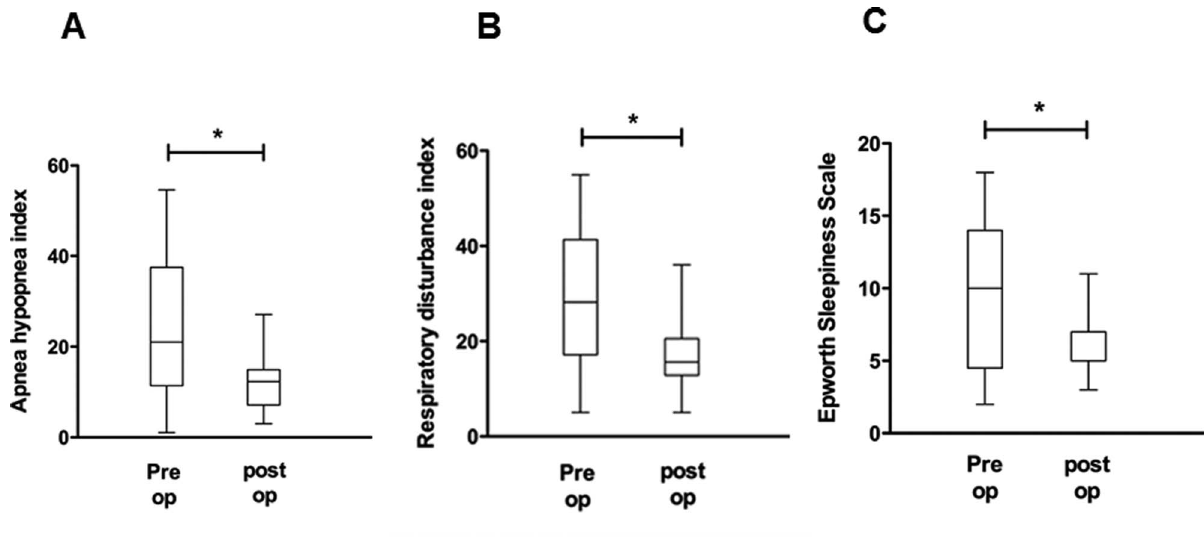
Figure 3. Changes in watch-PAT-derived factors, such as AHI (A), RDI (B), and ESS score (C), before and after nasal surgery. * : p , 0.05 when comparing the pre-and post-operative values.